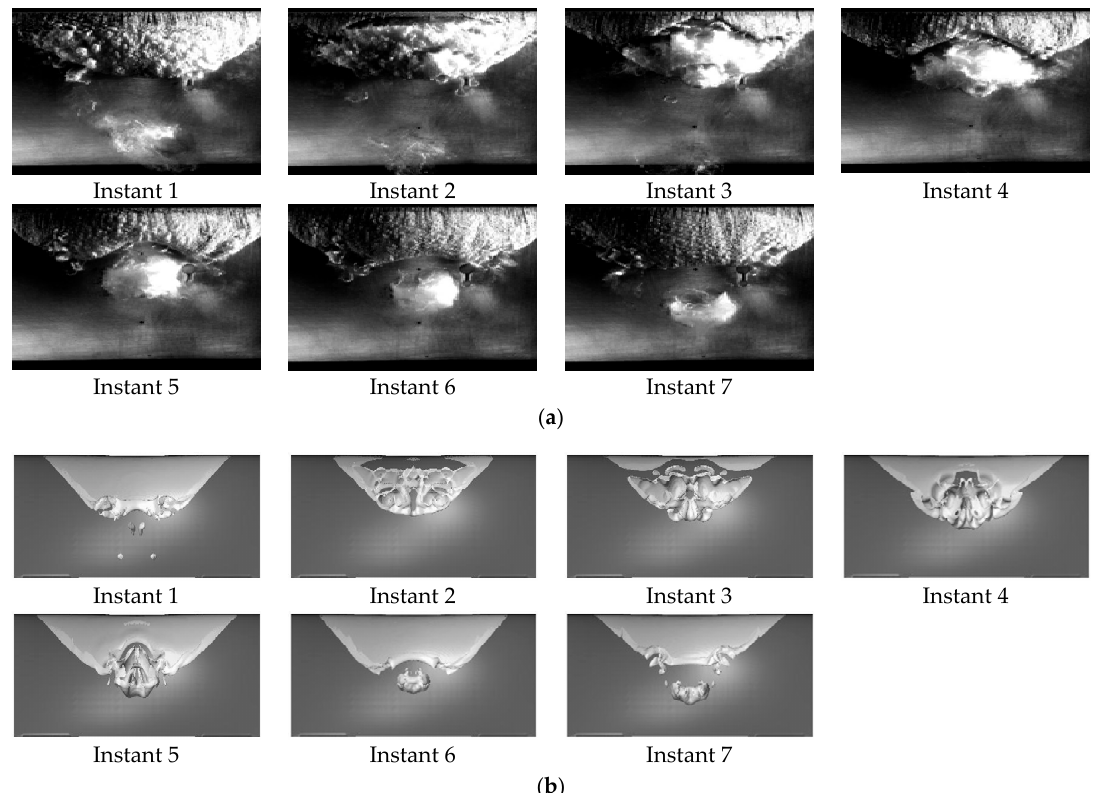
Figure 1. Comparisons of observed and predicted top view of the cavitation evolution process in one typical cycle ( σ = 1.07): ( a ) experimental data; and ( b ) predicted results. Table 2. The lift coefficient C L and the frequency f suggested by different documents. EXP: experiment; LES: large eddy simulation; and DES: detached eddy simulation.